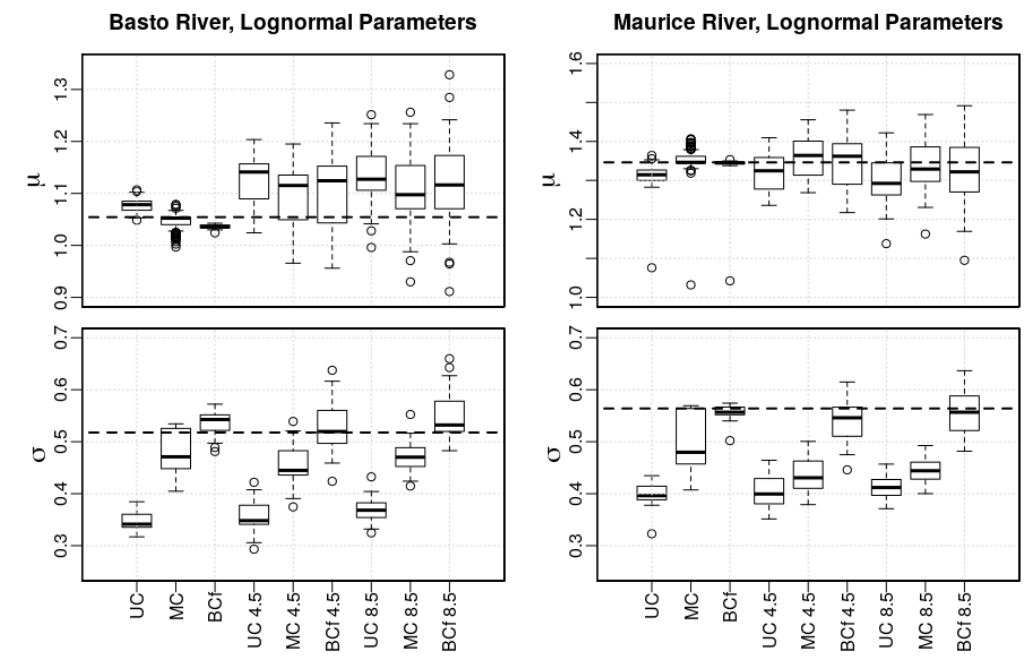
Figure 8. Lognormal distribution parameters, mean µ (top) and standard deviation σ (bottom), for uncorrected (UC), model-corrected (MC), and bias-corrected (BC) GCM simulations. UC, MC, and BC are GCM simulations for the historical period (1956–2005). Parameters are shown for GCM simulations for RCP 4.5 and RCP 8.5 for UC MC, and BC. Parameter values for observed fitted lognormal distributions are shown as the dotted line in each